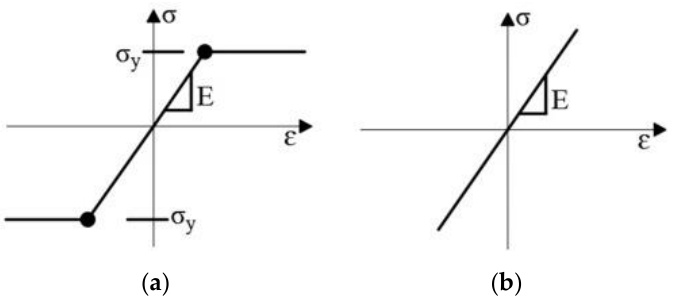
Figure 14. ( a ) Stress-strain law for steel reinforcement; ( b ) stress-strain curve for CFRP plates.